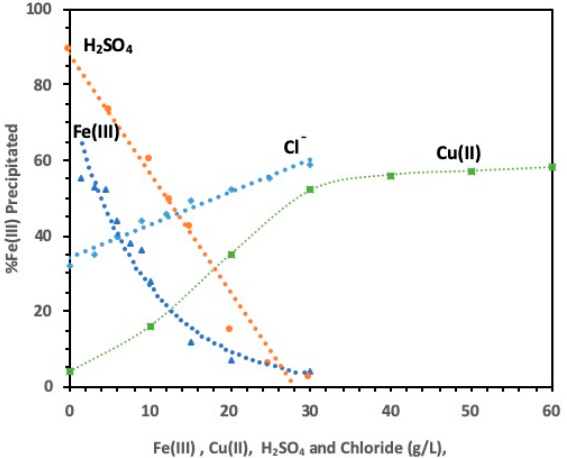
Figure A1. E ff ect of initial Fe(III), H 2 SO 4 , Cu(II), and chloride on %Fe(III) precipitation at 150 ◦ C for 1 h. Fe(III) line: 15 g / L H 2 SO 4 , 11g / L Cl − , 30 g / L Cu(II). H 2 SO 4 line: 6 g / L Fe(III), 11g / L Cl − , 30 g / L Cu(II). Cl − line: 6 g / L Fe(III), 15 g / L H 2 SO 4 , 30 g / L Cu(II). Cu(II) line: 6 g / L Fe(III), 15 g / L H 2 SO 4 , 11g / L Cl − . Data extracted and replotted from [26].